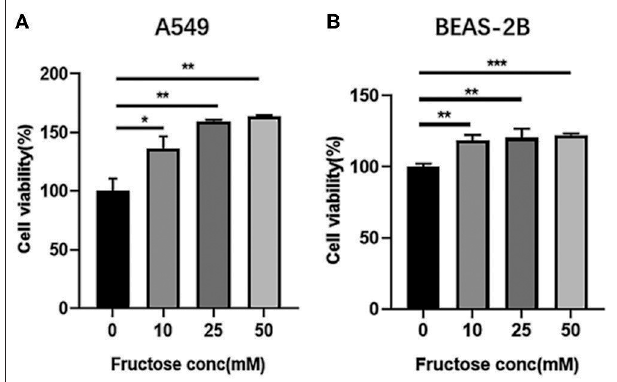
FIGURE 1 | Fructose promotes the cell viability of lung epithelial cells. A549 (A) and BEAS-2B (B) cells were cultured with different concentrations of fructose (0, 10, 25, and 50mM) for 24h, and then a CCK-8 assay was performed to detect the cell viability. Data were expressed as Mean ± S.E.M ( n = 3) and analyzed using one-way ANOVA followed by Tukey’s test. * p < 0.05, ** p < 0.01, and *** p < 0.001 vs. 0 mM fructose.